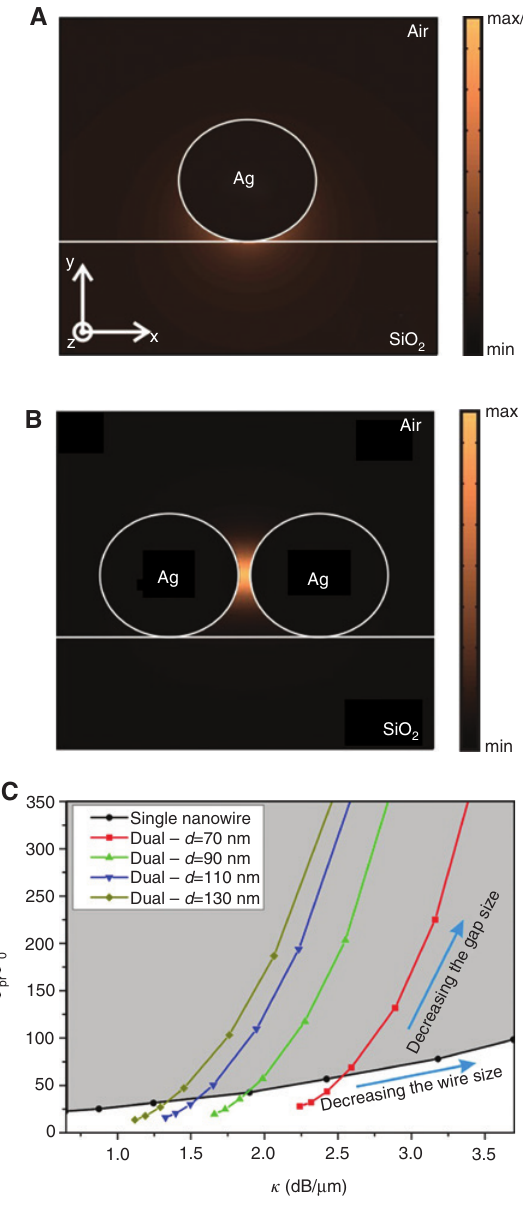
Figure 4: Pointing vector of the guided surface plasmon mode on (A) a single nanowire and (B) the antisymmetric gap mode with a separation of 9 nm between the wires. (C) Comparison of the normalized decay rate into the plasmon mode Γ single and the dual nanowire configuration, parameterized as a function of linear propagation loss κ . All graphs are taken from Ref.